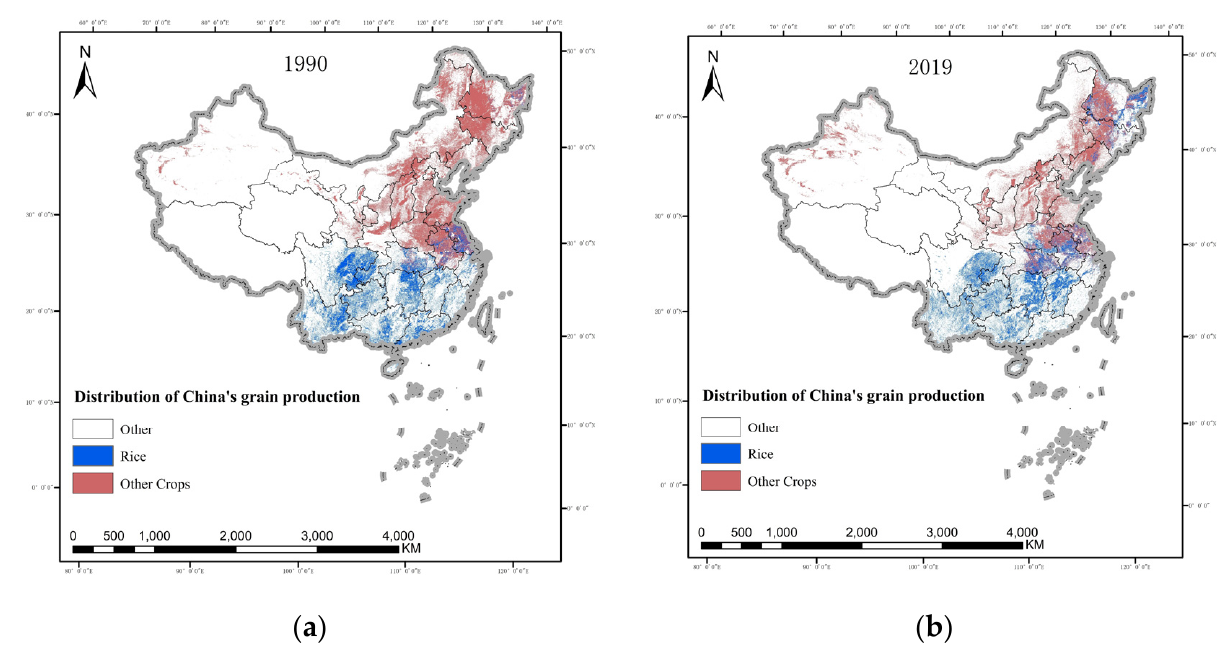
Figure 1. Distribution of grain production in China from ( a )1990 to ( b )2019.